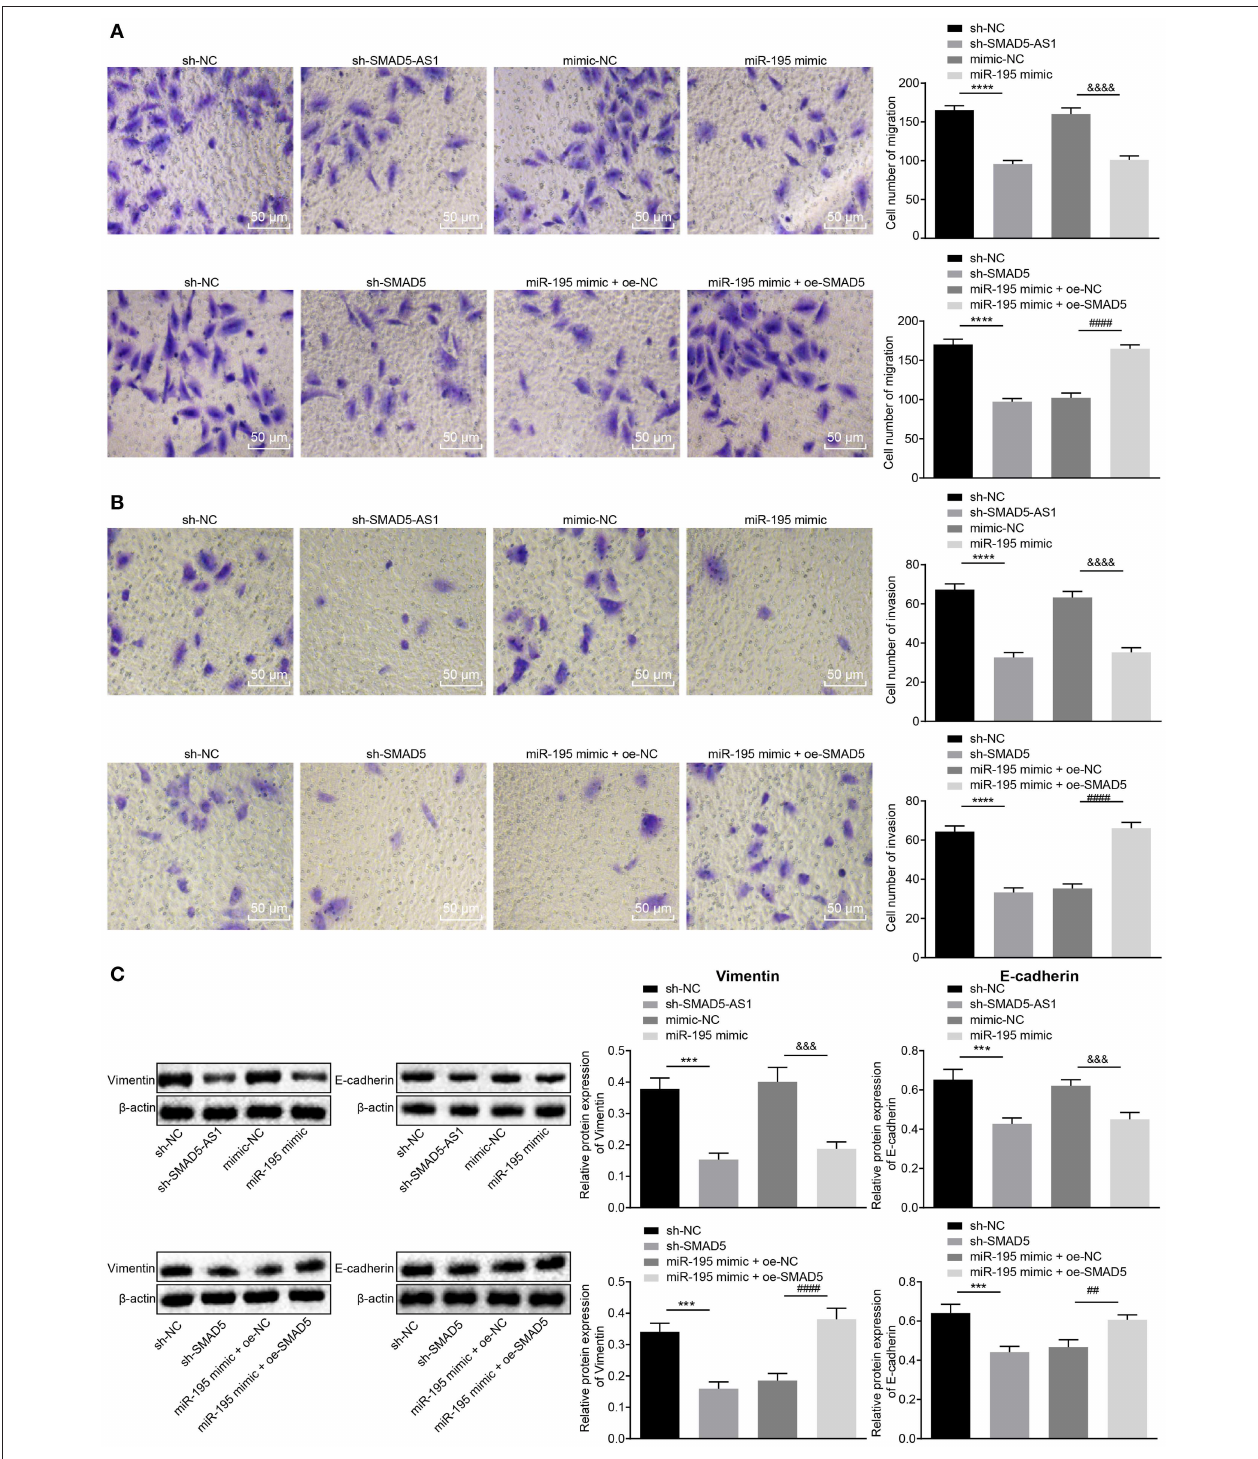
FIGURE 5 | CNE-2 cell invasion, migration, and EMT were inhibited following silencing of SMAD5-AS1 or SMAD5 or upregulation of miR-195. (A) CNE-2 cell migration based on Transwell assay (200 × , scale bar = 50 um). (B) CNE-2 cell invasion based on Transwell detection (200 × , scale bar = 50 um). In (A,B) , **** p < 0.0001 vs. the sh-NC group; &&&& p < 0.0001 vs. the mimic-NC group; #### p < 0.0001 vs. the miR-195 mimic + oe-NC group. (C) The protein expression of Vimentin and E-cadherin in CNE-2 cells determined by western blot analysis, *** p < 0.001 vs. the sh-NC group; &&& p < 0.001 vs. the mimic-NC group; #### p < 0.0001 vs. the miR-195 mimic + oe-NC group; ## p < 0.01 vs. the miR-195 mimic + oe-NC group. The statistical data were measurement data and expressed as mean ± standard deviation. n = 6. Independent sample t -test was adopted to compare data between two groups. The experiment was repeated 3 times.